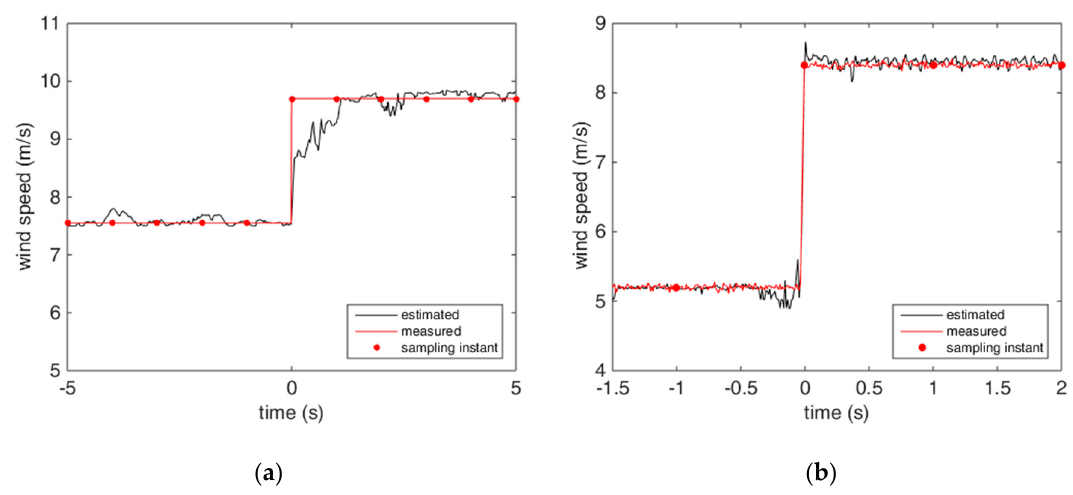
Figure 8. Estimated and measured wind speed profiles: ( a ) 5.5 kW HAWT; ( b ) 1 kW VAWT. Red dots highlight the sampling instants of the real anemometer.